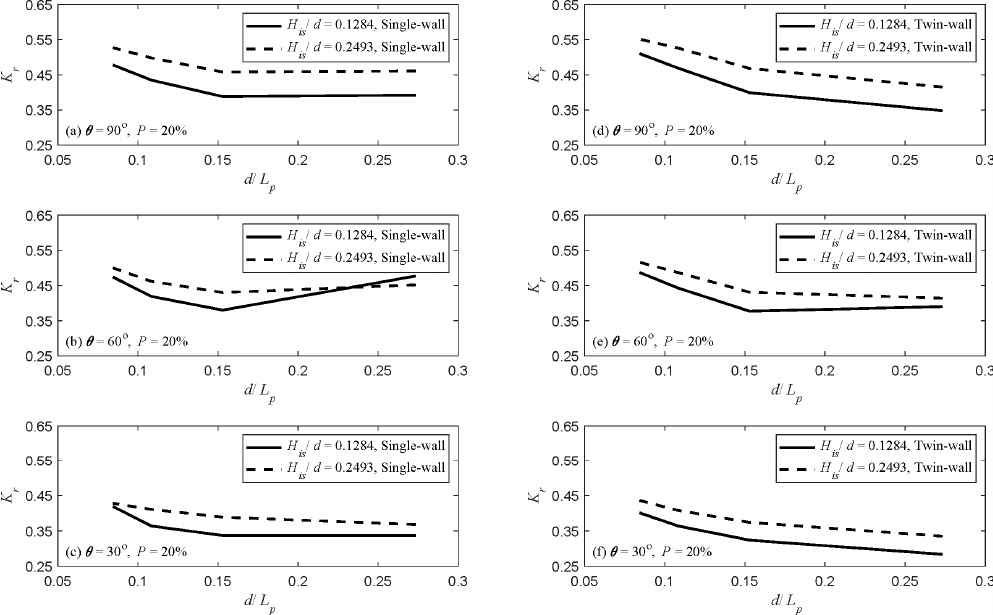
Figure 20. Effect of H is / d on K r for P = 20% and different wall slopes. Subfigures ( a ), ( b ), and ( c ) are for single-wall, and subfigures ( d ), ( e ), and ( f ) are for twin-wall.